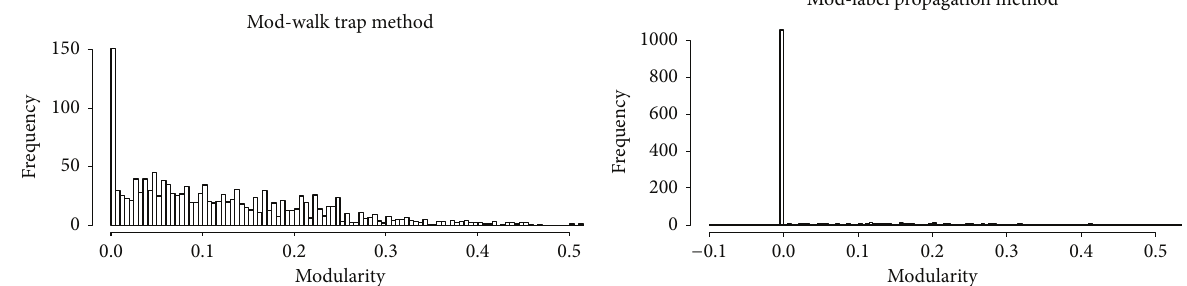
Figure 7: Modularity distribution following the community detection for all nested groups. Modularity values are generally poor while, in most cases, a further subdivision of the nested group is not